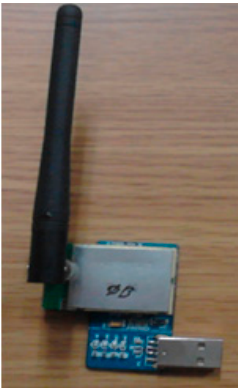
Figure 8. Receiver for the ZigBee communication protocol with a USB interface.